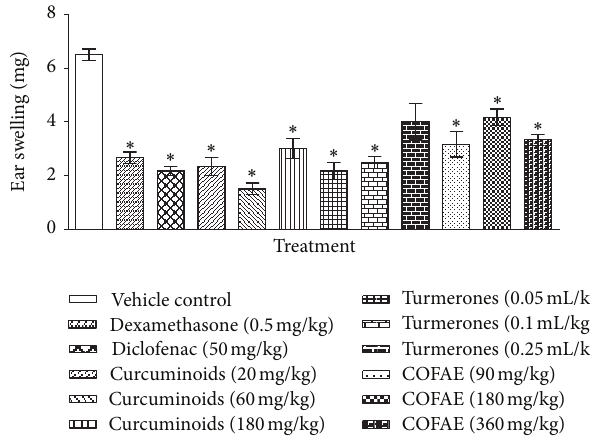
Figure 1: Effect of curcuminoids, turmerones, and COFAE on xylene-induced ear edema in mice.